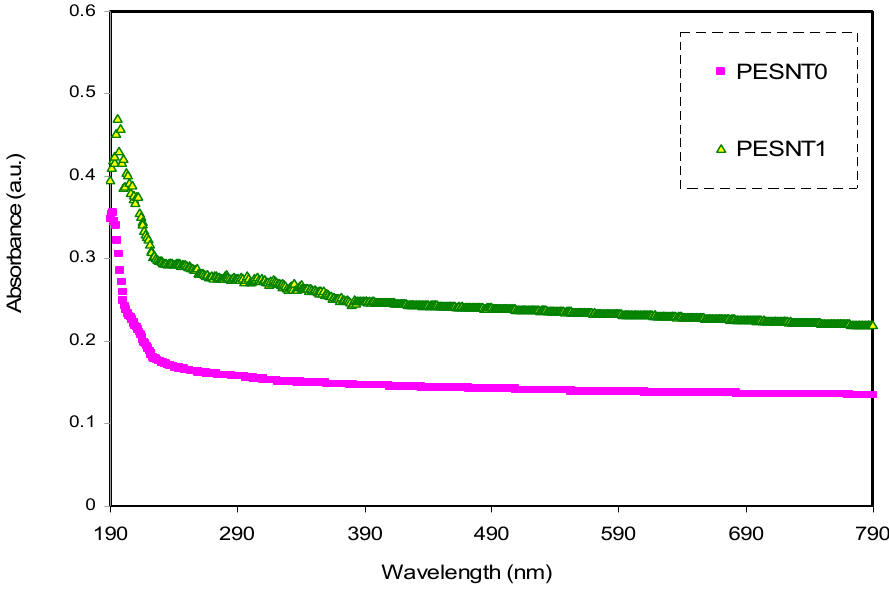
Figure 2. Pure PEO (PESNT0) and PESNT1 composite samples’ optical absorption spectra.